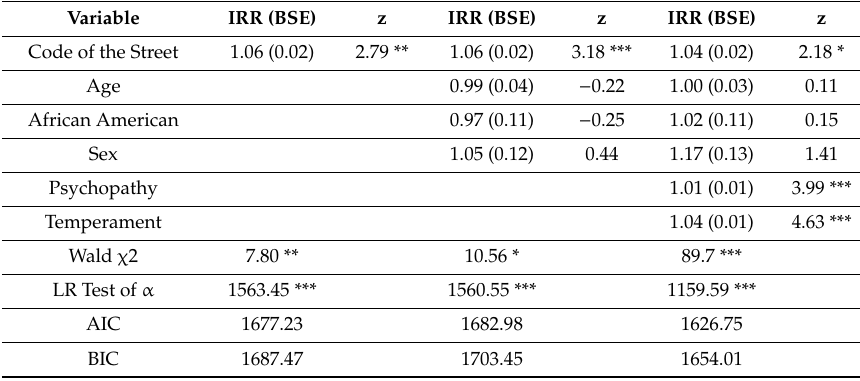
Table 2. Negative binomial regression models for self-reported